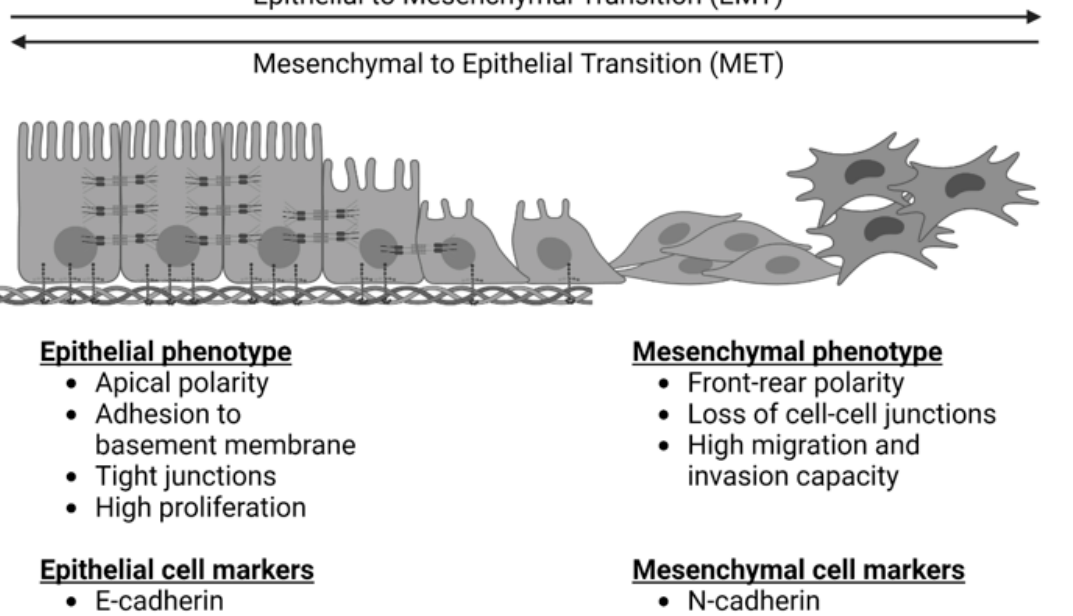
Figure 1. The epithelial to mesenchymal transition (EMT) and the reverse process of the mesenchymal to epithelial transition (MET). EMT is characterized by a loss of epithelial cell markers, an increase in mesenchymal cell markers, a loss of apical cell polarity, a loss of tight cell junctions, and an increased capacity for cell migration and invasion. MET is characterized by a loss of mesenchymal cell markers, an increase in epithelial cell markers, increased apical cell polarity, tight junctions, adherence to a basement membrane, and increased cell proliferation.